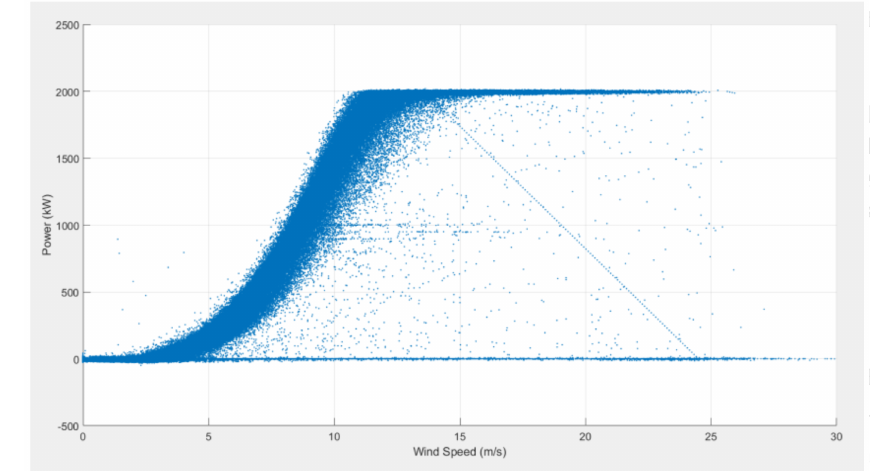
Figure 2. Operating values and their